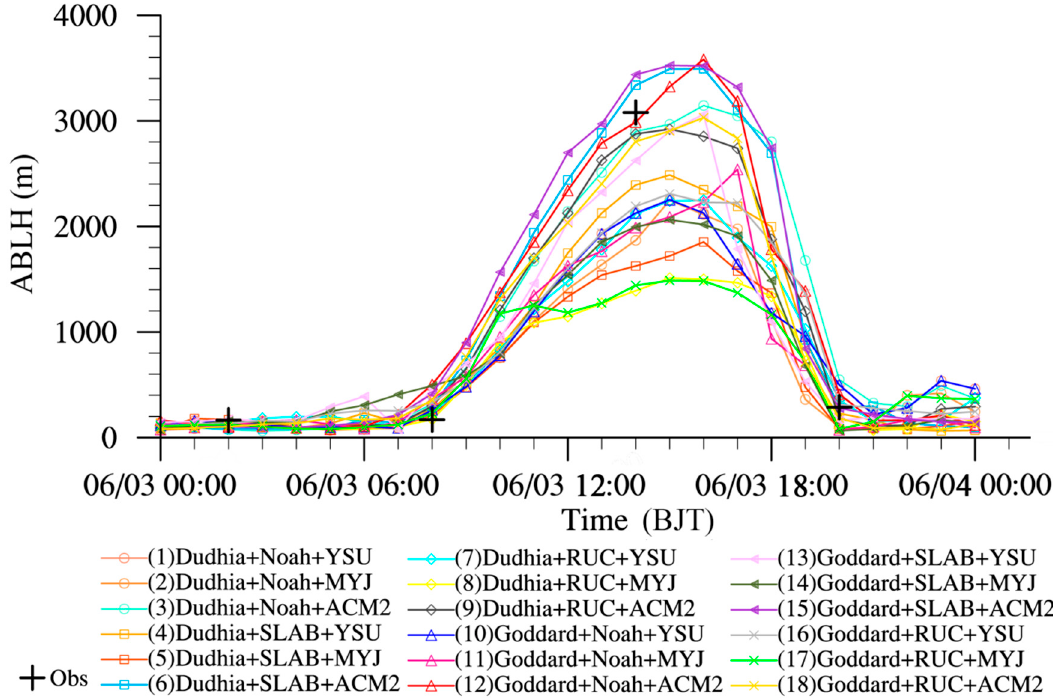
Figure 11. Numerical simulation of Yuzhong using different combinations of parameterization schemes and calculation of boundary layer heights with ERA-Interim model level data from 16:00 on 2 June, 2016, to 16:00 on 3 June, 2016.